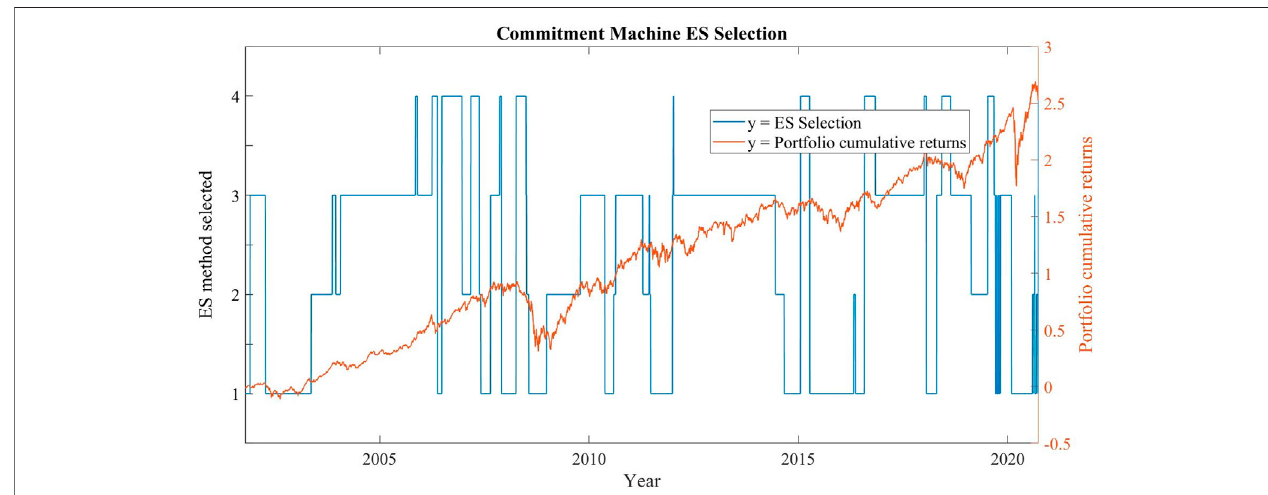
FIGURE 3 | Commitment machine ES